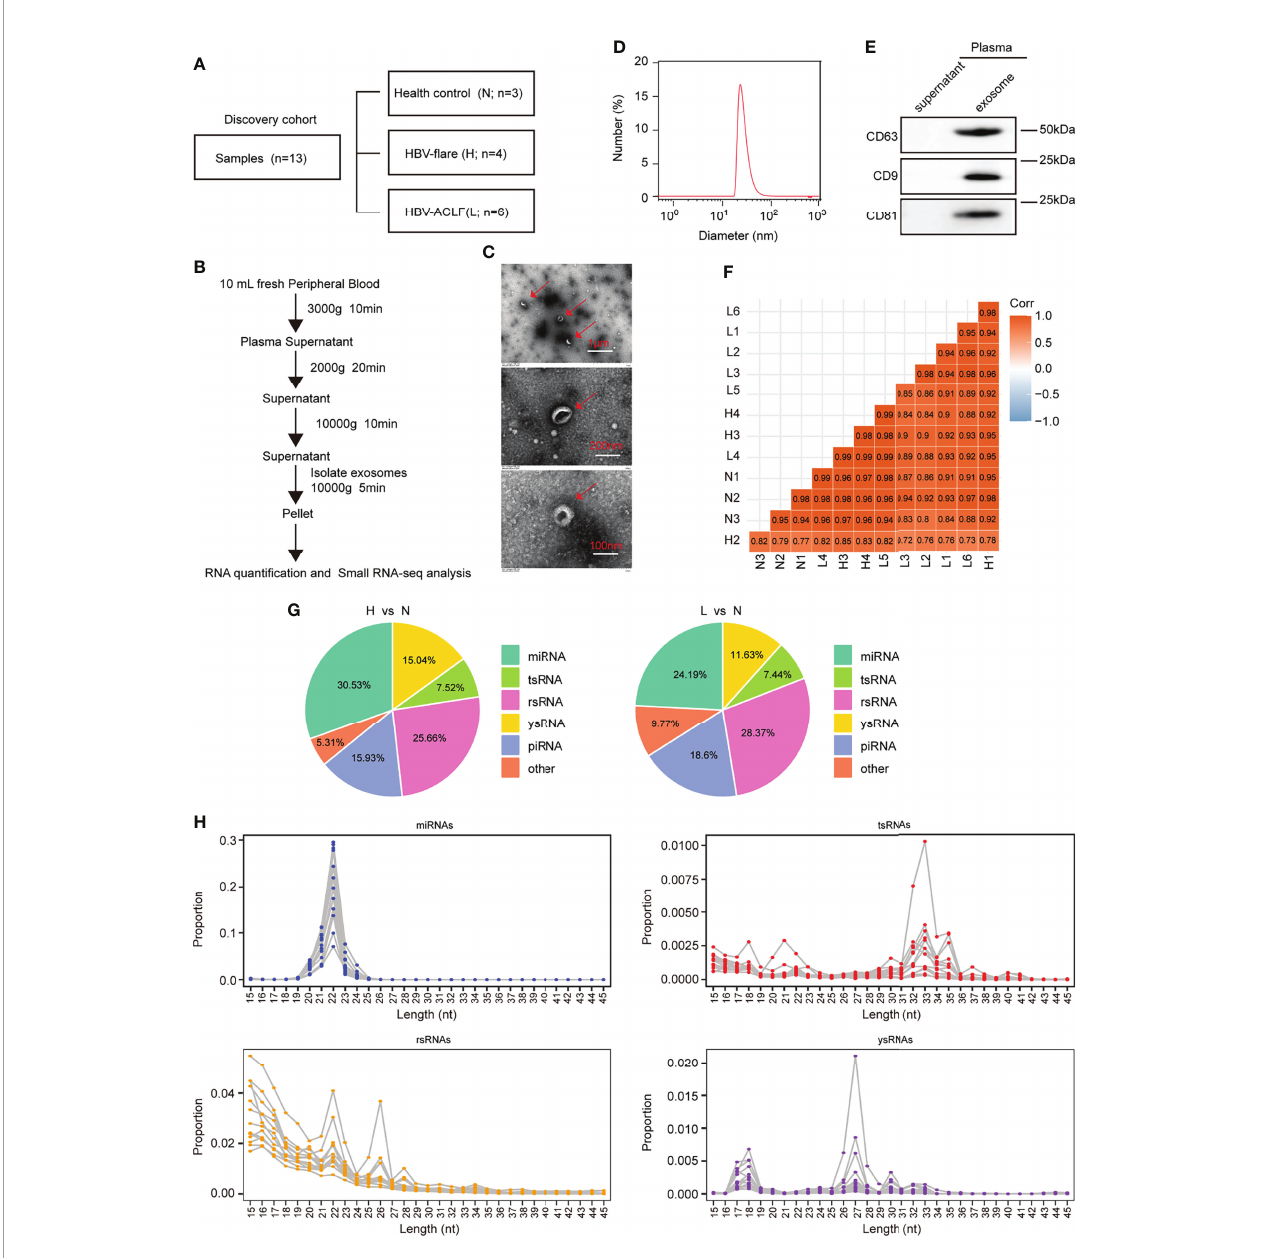
FIGURE 1 | Pro fi ling of sncRNAs in exosomes from patient plasma. (A) The samples included 3 healthy controls (marked as N), 4 HBV- fl are patients (marked as H), and 6 HBV-ACLF patients (marked as L) for exosome small RNA-seq as the discovery cohort. (B) Exosome collection procedure from patient plasma. (C) TEM on plasma exosomes in ACLF patients (The scale bar is 1 m m, 200 nm, and 100 nm, respectively). (D) Nanoparticle tracking analysis (NTA) of exosomes isolated from ACLF patient plasma. (E) Western blot analysis for plasma exosomal protein. (F) Correlation of 13 sncRNA-seq. (G) sncRNA percentages between the two comparison groups: H vs. N and L vs. N. (H) The length distribution of the four types of sncRNAs, miRNAs, tsRNAs, rsRNAs, and ysRNAs. Each dot represents one plasma exosome sample. The Y-axis presented the read proportion within each sncRNA